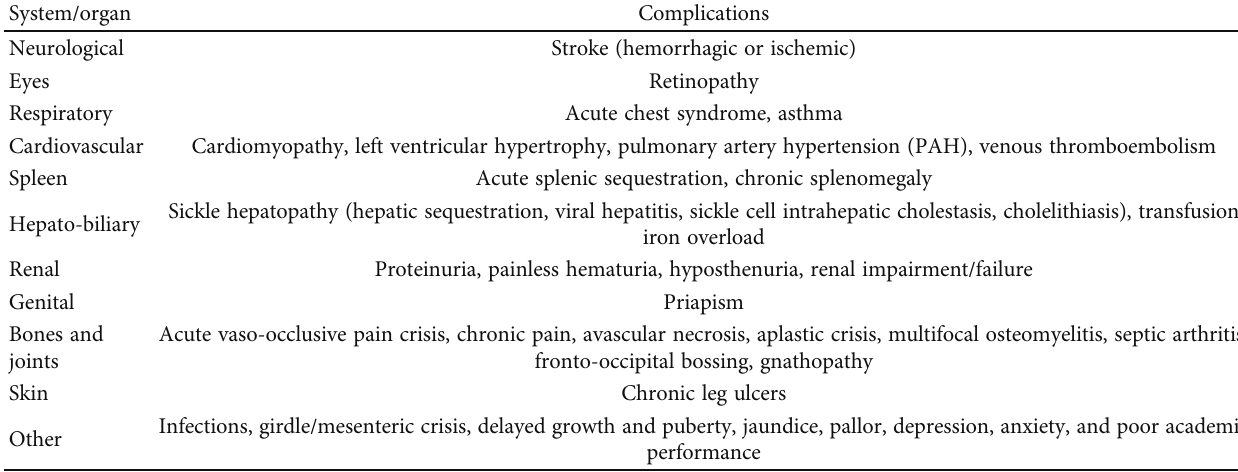
Table 1: Clinical presentation and complications of